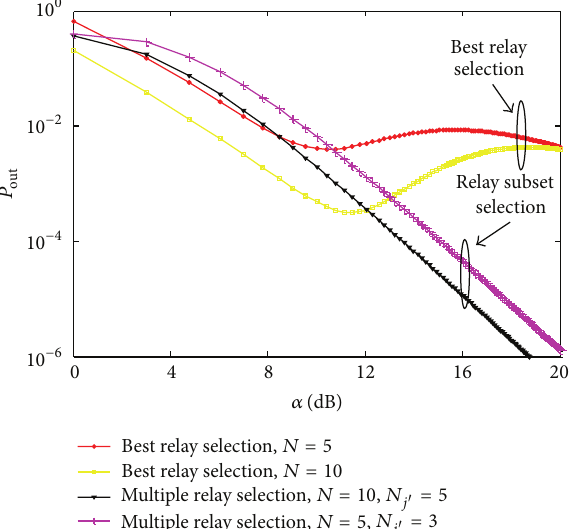
= 1 and 𝜁 = 1 for different sizes of potential Figure 5: BER with 𝛾 th relay